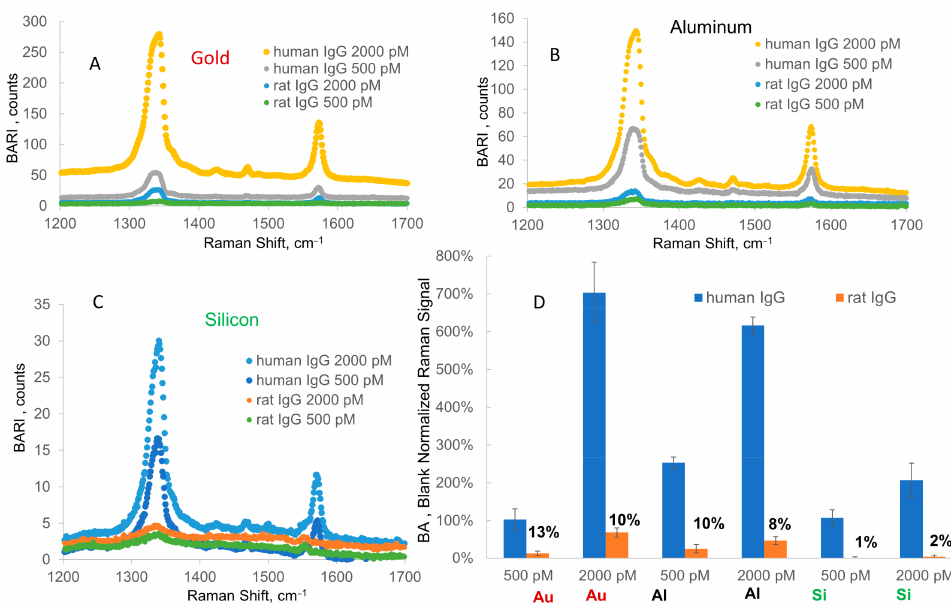
Figure 4. SERS blank-adjusted spectra in selectivity assay: human and rat IgG response on ( A ) hold, ( B ) Al tape, and ( C ) Si wafer. ( D ) Blank-adjusted blank-normalized Raman intensity/signal for each substrate (IgG concentrations of 500 and 2000 pM). Here, the response/signal for each concentration is normalized to the response for a blank on each substrate (13%, 10%, etc.), showing the ratios of nonspecific (rat IgG) to specific (human IgG) signals for each concentration using gold, aluminum, and silicon.